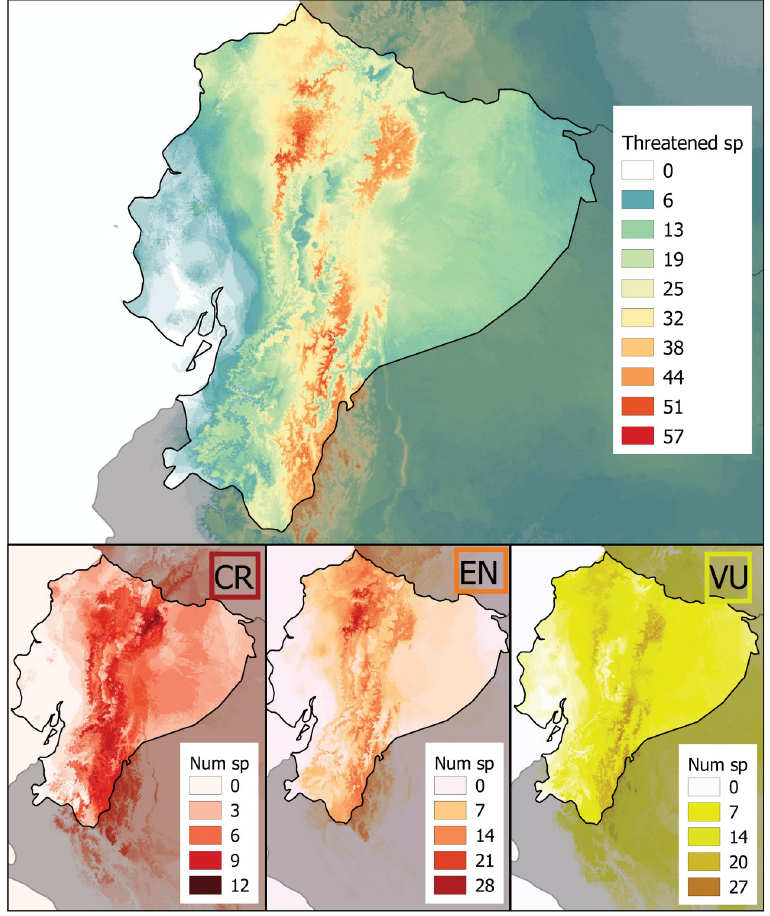
Fig 6. Cumulative species richness for threatened taxa ( n = 265 models) by Red List category. Maps with cumulative species (Num sp) models per category and family are shown in S3–S5 Figs.